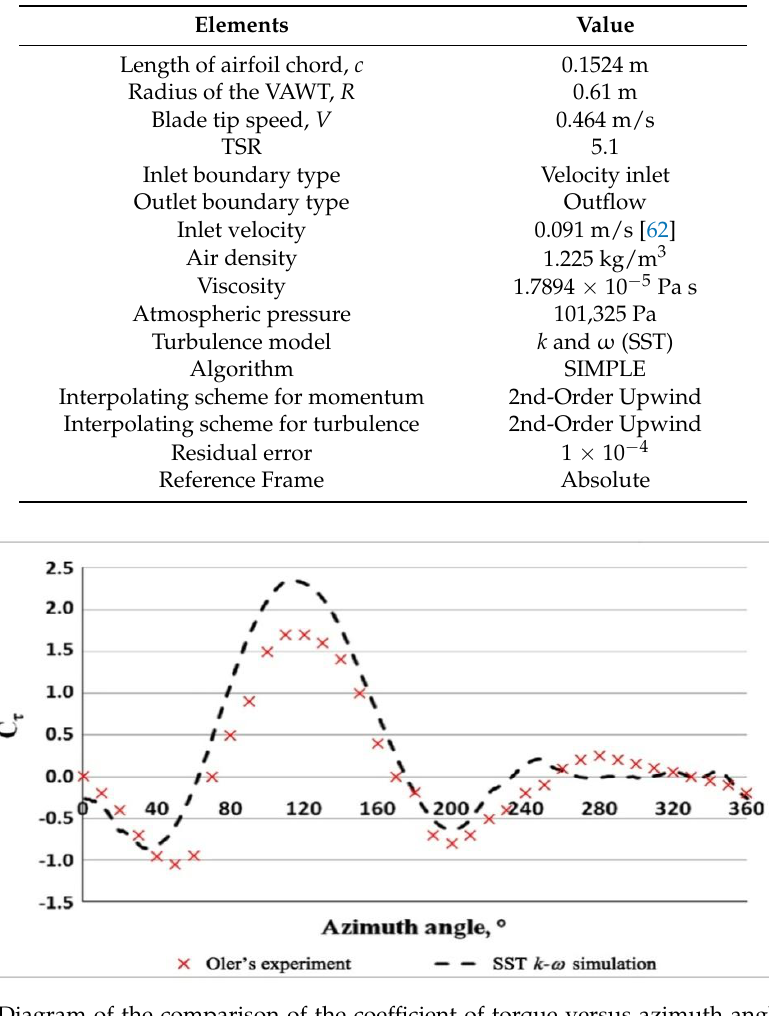
Figure 16. Diagram of the comparison of the coefficient of torque versus azimuth angle in Oler’s experiment and the simulation ( TSR = 5.1). Reprint with permission [63]; 2012, University of Malaya.